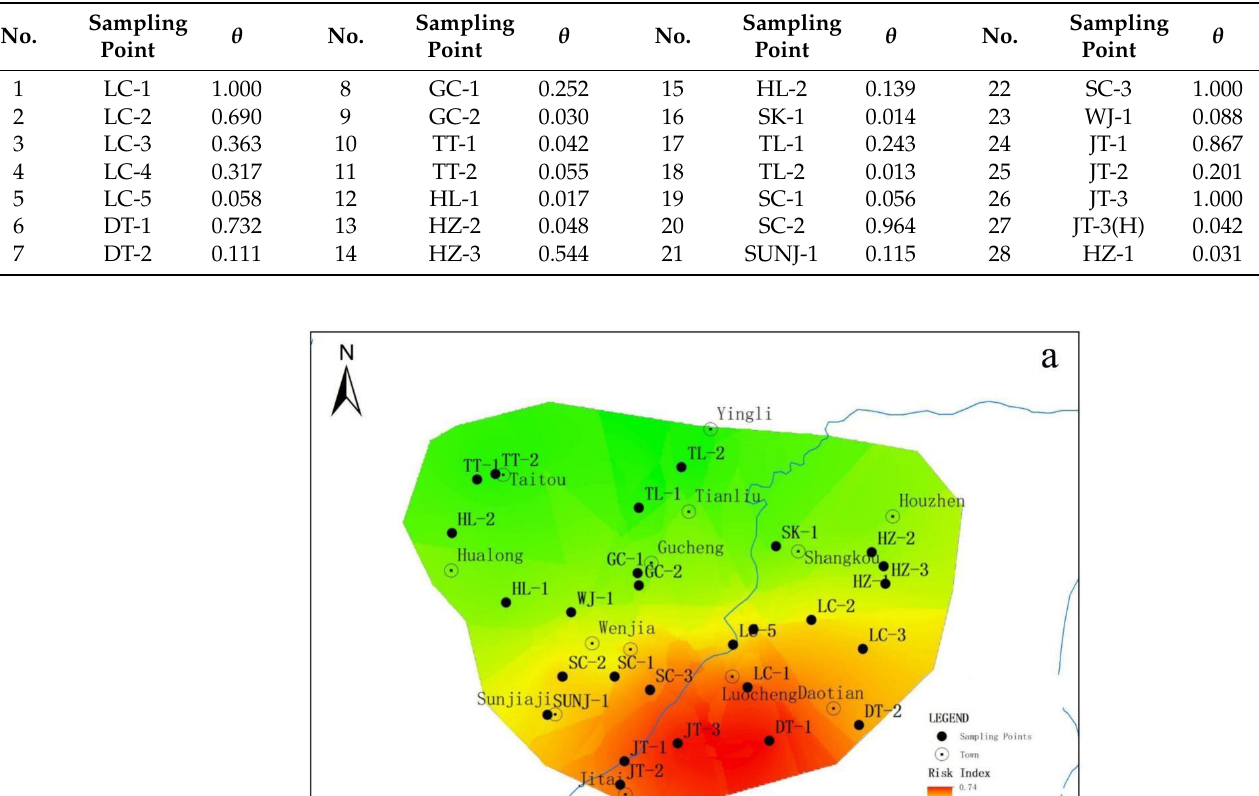
Table 3. Calculation of nitrate pollution risk index of shallow groundwater in the Mihe alluvial– diluvial fan.